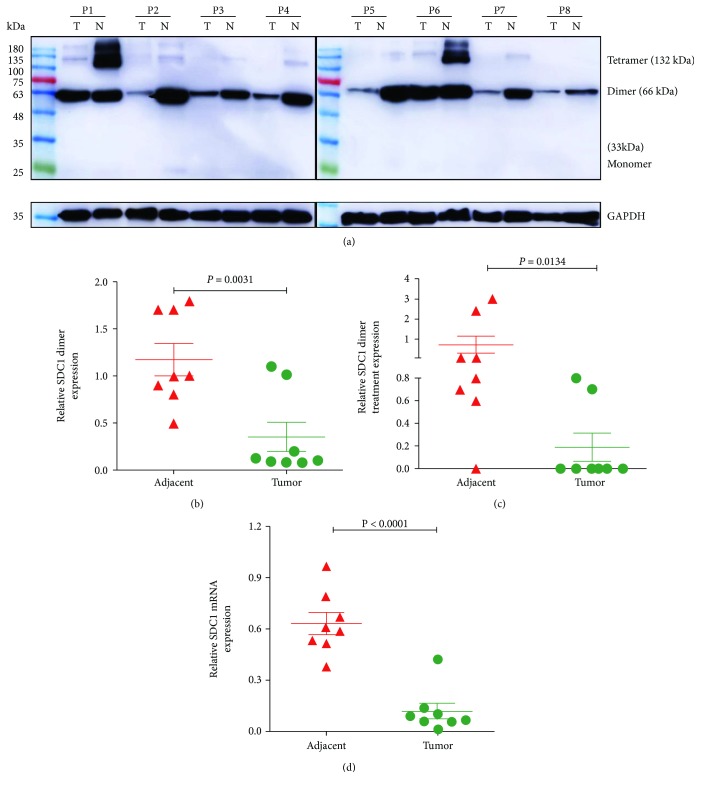
SDC1 expression is decreased in CRCs. (a) Protein expression levels were evaluated in colorectal biopsies taken from 8 tumors (CRCs, T) and adjacent non-neoplastic controls (N) by Western blot. GAPDH was used as a loading control. Quantitative analysis of SDC1 protein: (b) dimer level (p = 0.0031, Student's t-test) and (c) tetramer level (p < 0.0001, Mann-Whitney test) in CRC and paired, adjacent non-neoplastic controls. (d) mRNA expression levels were evaluated in colorectal biopsies and adjacent non-neoplastic controls by qRT-PCR. GAPDH was used as a control. p < 0.0001, Student's t-test.